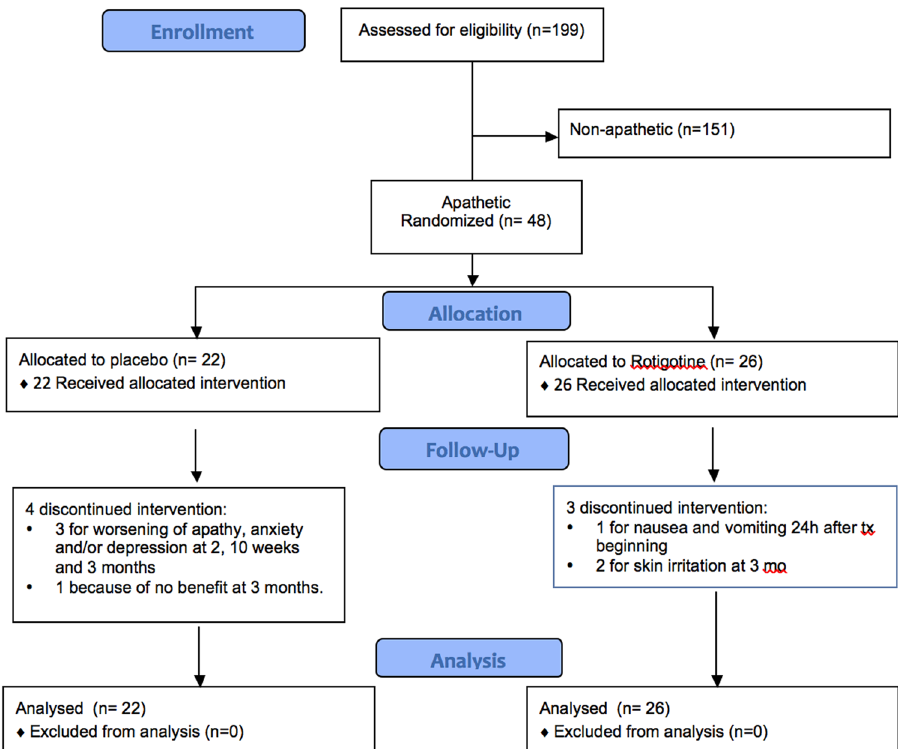
Fig. 1 Consort fl ow diagram. Screening of de novo PD patients for apathy, randomization to rotigotine or placebo, follow-up and analysis. Table 1. Baseline characteristics of